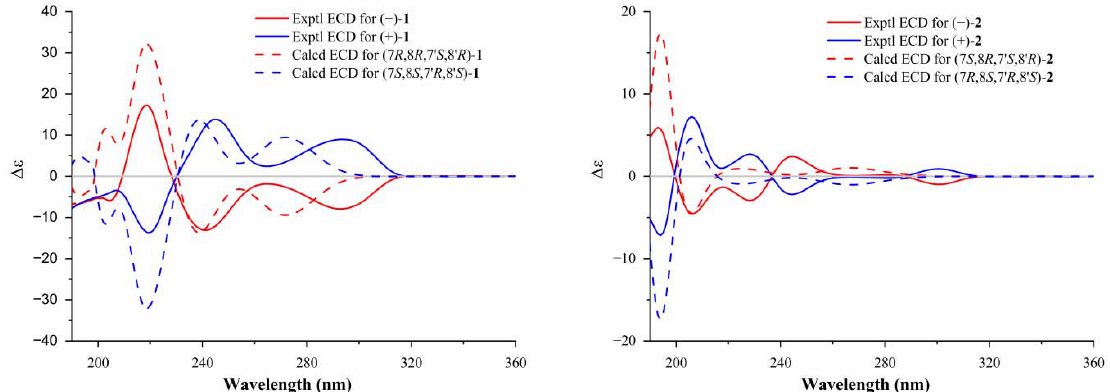
Figure 2. Experimental and calculated ECD spectra of 1 and 2